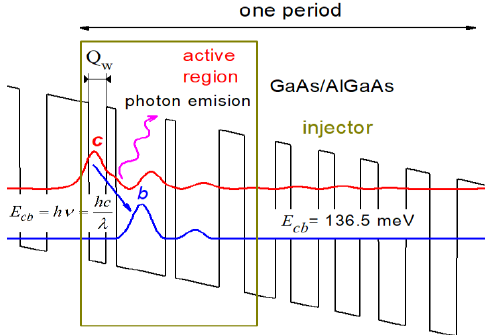
Figure 5. A scheme for modeling QCL active region.